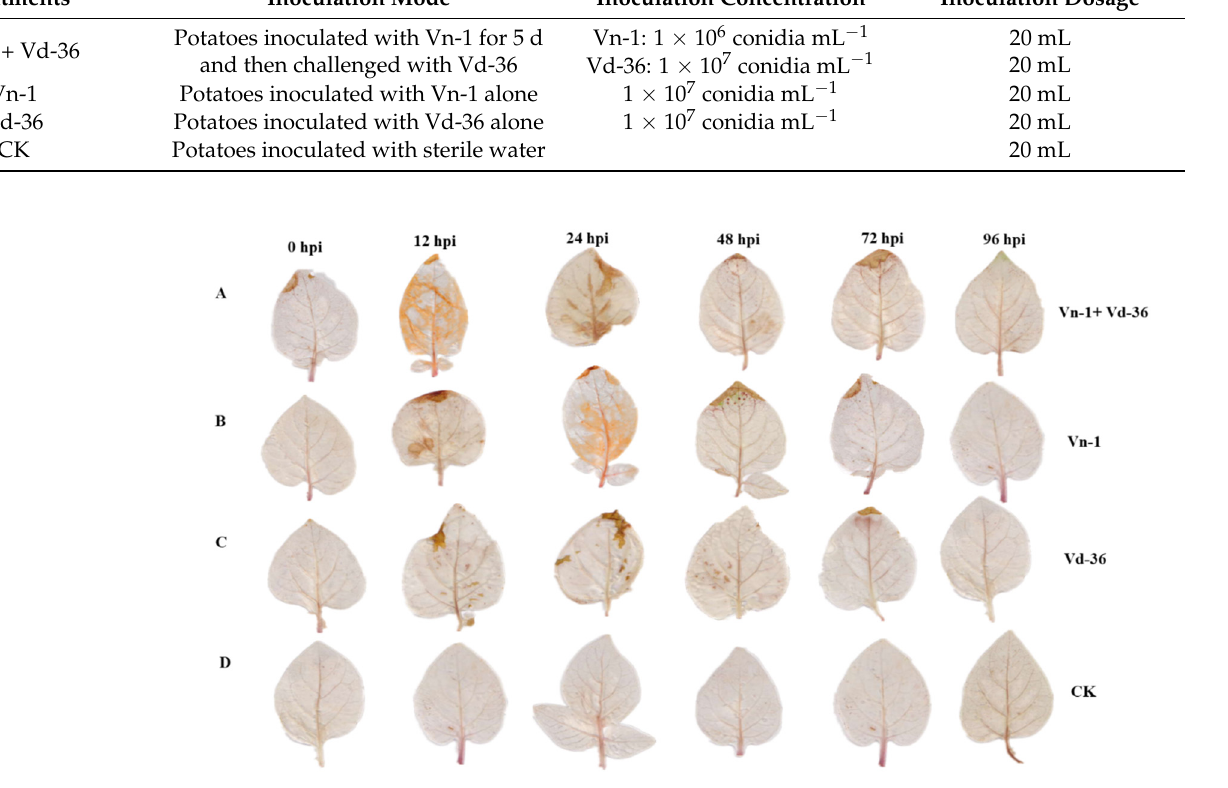
Figure 2. Reactive oxygen species (ROS) burst in different treatments as assessed by 3,3’ ‐ diamino ‐ benzidine (DAB) staining: ( A ) potatoes inoculated with Vn ‐ 1, followed by Vd ‐ 36 inoculation after 5 d; ( B , C ) potatoes inoculated with Vn ‐ 1 and Vd ‐ 36 alone, respectively; ( D ) sterile water was used to inoculate the controls.